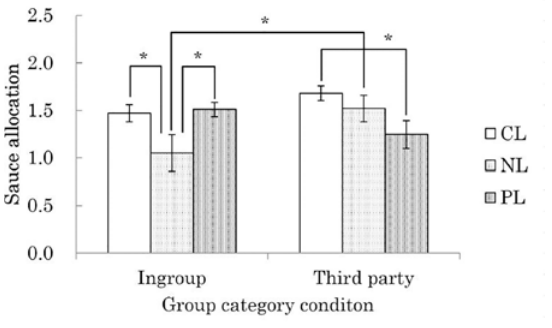
Fig 3. Effects of group category and labeling in the hot sauce